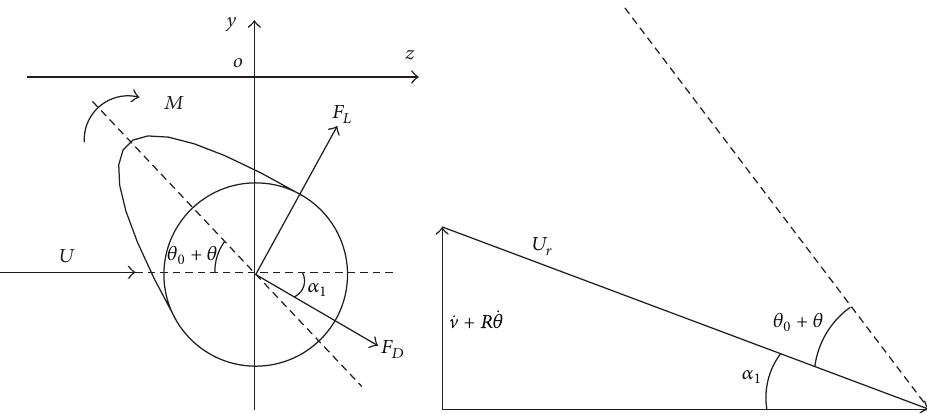
Figure 3: The aerodynamic model of iced